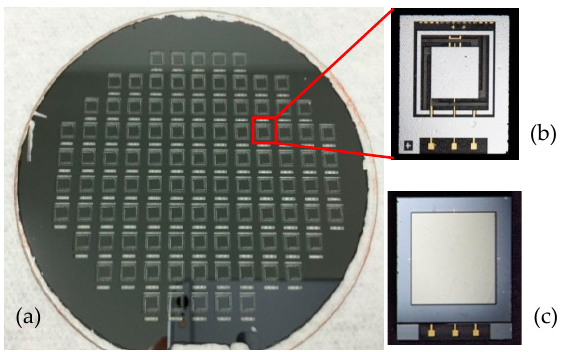
Figure 11. Photographs of fabricated accelerometers. ( a ) The chips on the whole wafer; ( b ) a signal chip without glass cover; ( c ) the hermetically packaged chip.